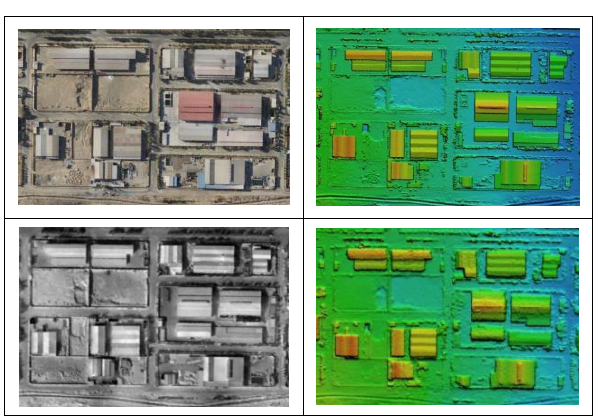
Figure 4. Orthomosaic and DEM of visible (Top) and thermal images